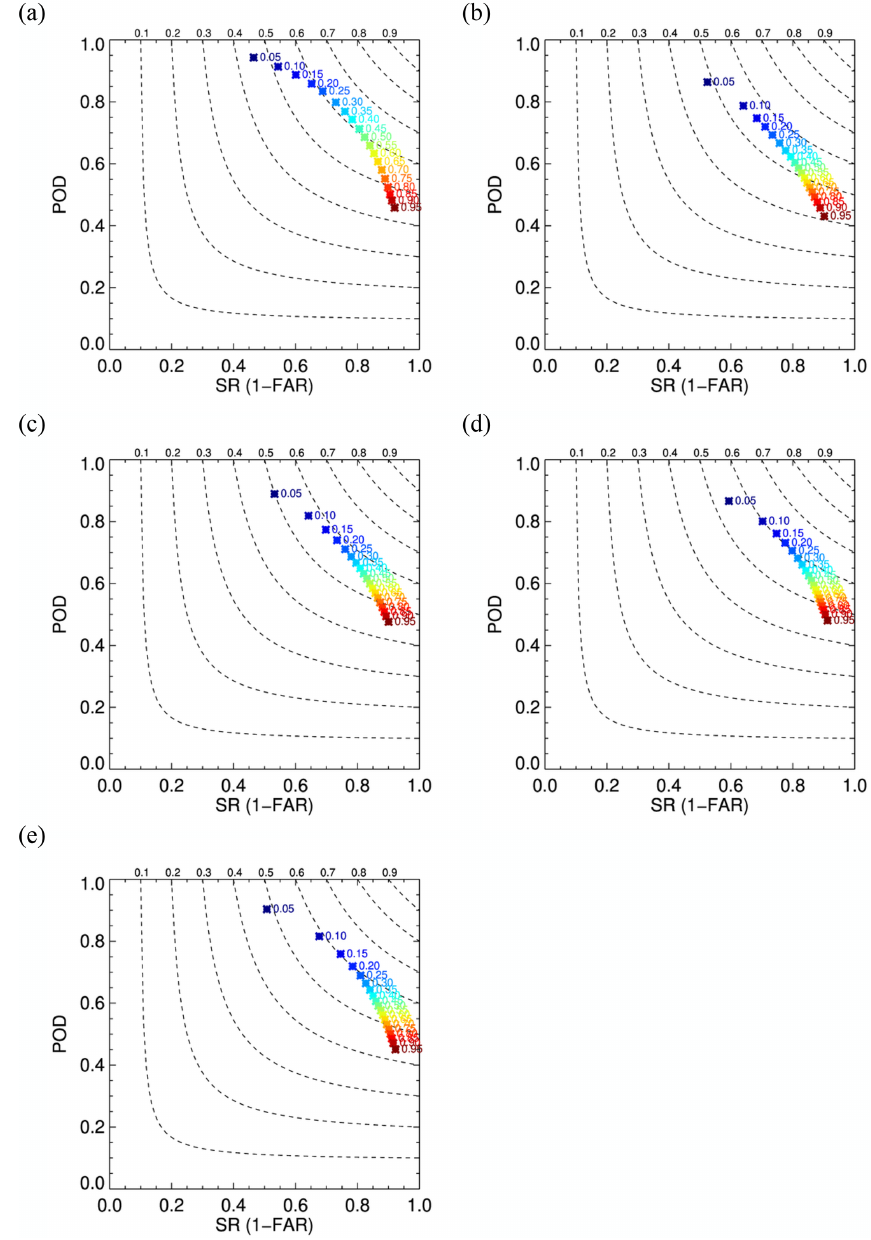
Figure 14. (a) Performance diagram in Fig. 3a is shown here for ease of comparison. Performance diagrams using (b) only channel 2 reflectance images, (c) one static image, (d) two images with 8min intervals, and (e) three images with 4min